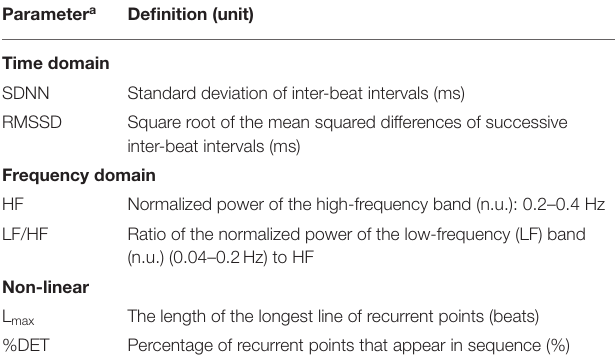
TABLE 1 | Definitions of HRV